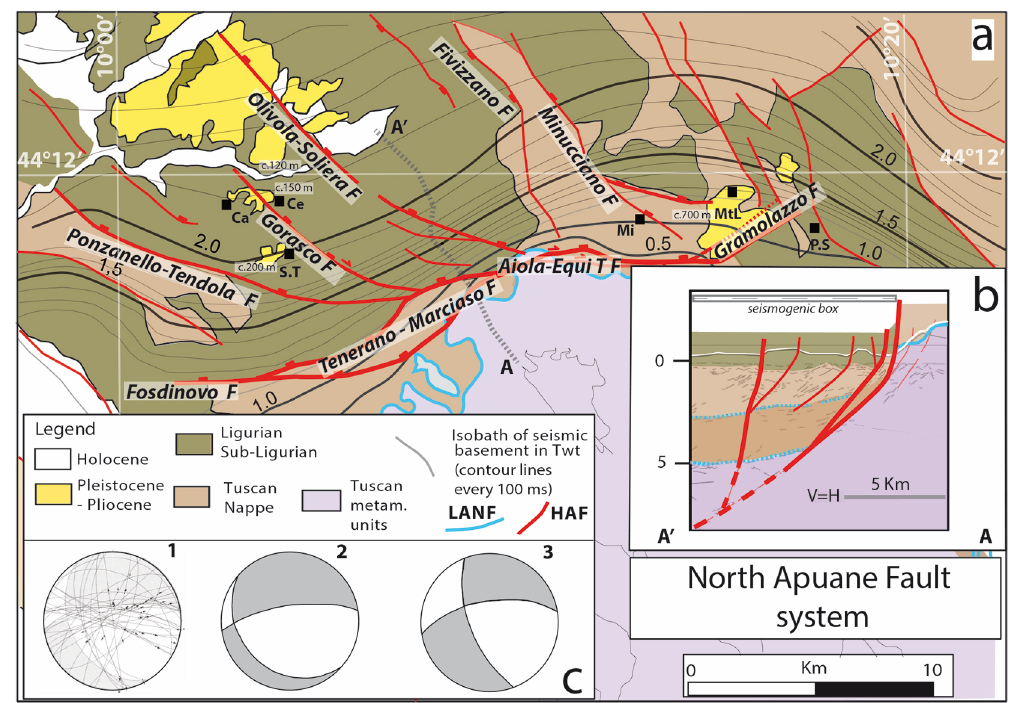
Figure 7. Lunigiana–Garfagnana linkage domain between SD2 and SD3, with the surface and subsurface architecture of the North Apuane Fault System. ( a ) Simplified tectonic and geological map of the Lunigiana–Garfagnana linkage domain (location in Figure 3) with breakthrough surface faults (Fosdinovo–Tenerano–Marciaso–Aiola–Equi T.–Gramolazzo and splays). HAF: steep normal faults; LANF: low-angle detachment faults. The contours are depths (in TWT) of the seismic basement identified in the seismic profiles, down to 5000 m; they image the North Apuane fault plane in the subsurface, as shown in ( b ). Numbers c.000 m indicate the elevation of the base of Plio-Pleistocene deposits. ( b ) Interpreted seismic section across the North Apuane fault (ENI: Equi Terme–Monti migrated line; more details in [50]). ( c ) Fault data (main fault planes and secondary faults with striations) showing kinematics of Aiola–Equi Terme Fault (1) and fault slip data inversion, PT kinematic diagrams (2, 3). All kinematic indicators attest to an oblique slip, both normal and right-lateral. Ca: Canova;